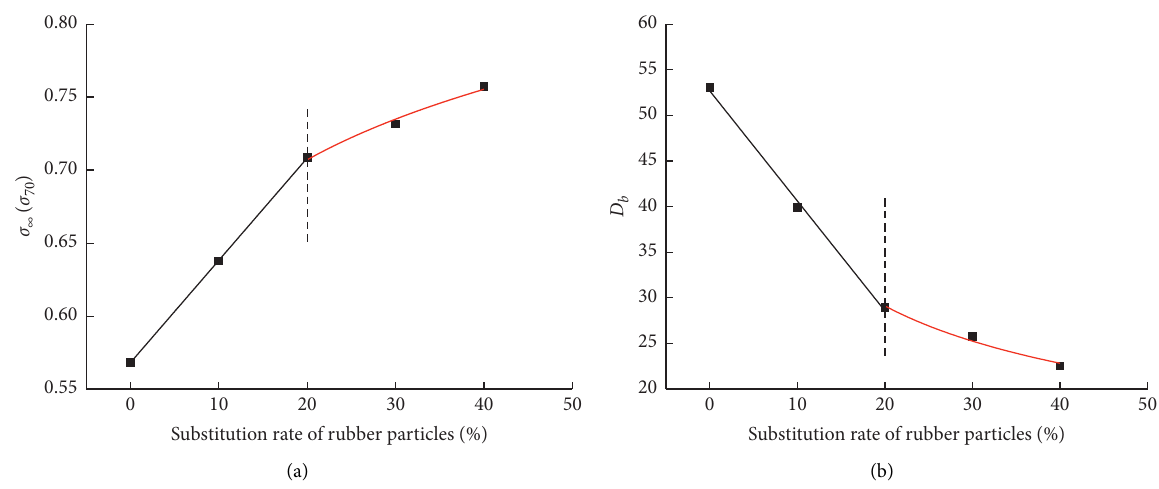
Figure 16: Relationship between the rubber substitution rate and the size effect law parameters. (a) σ strength. (b) D b structure